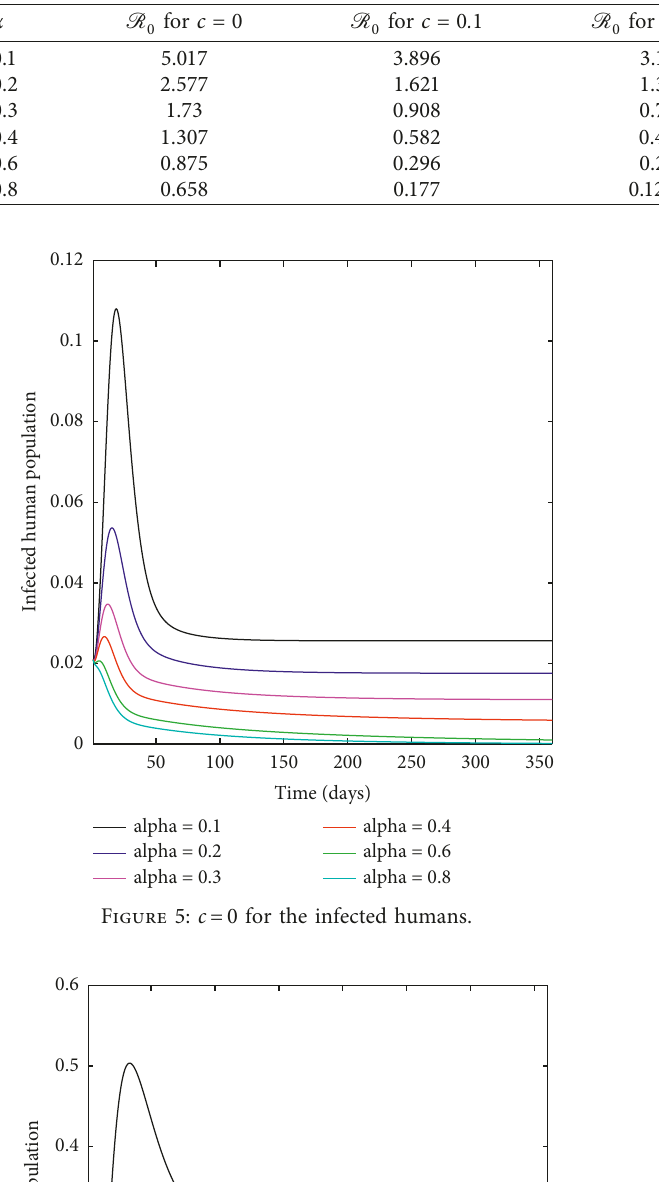
Table 5: Table showing the value of R